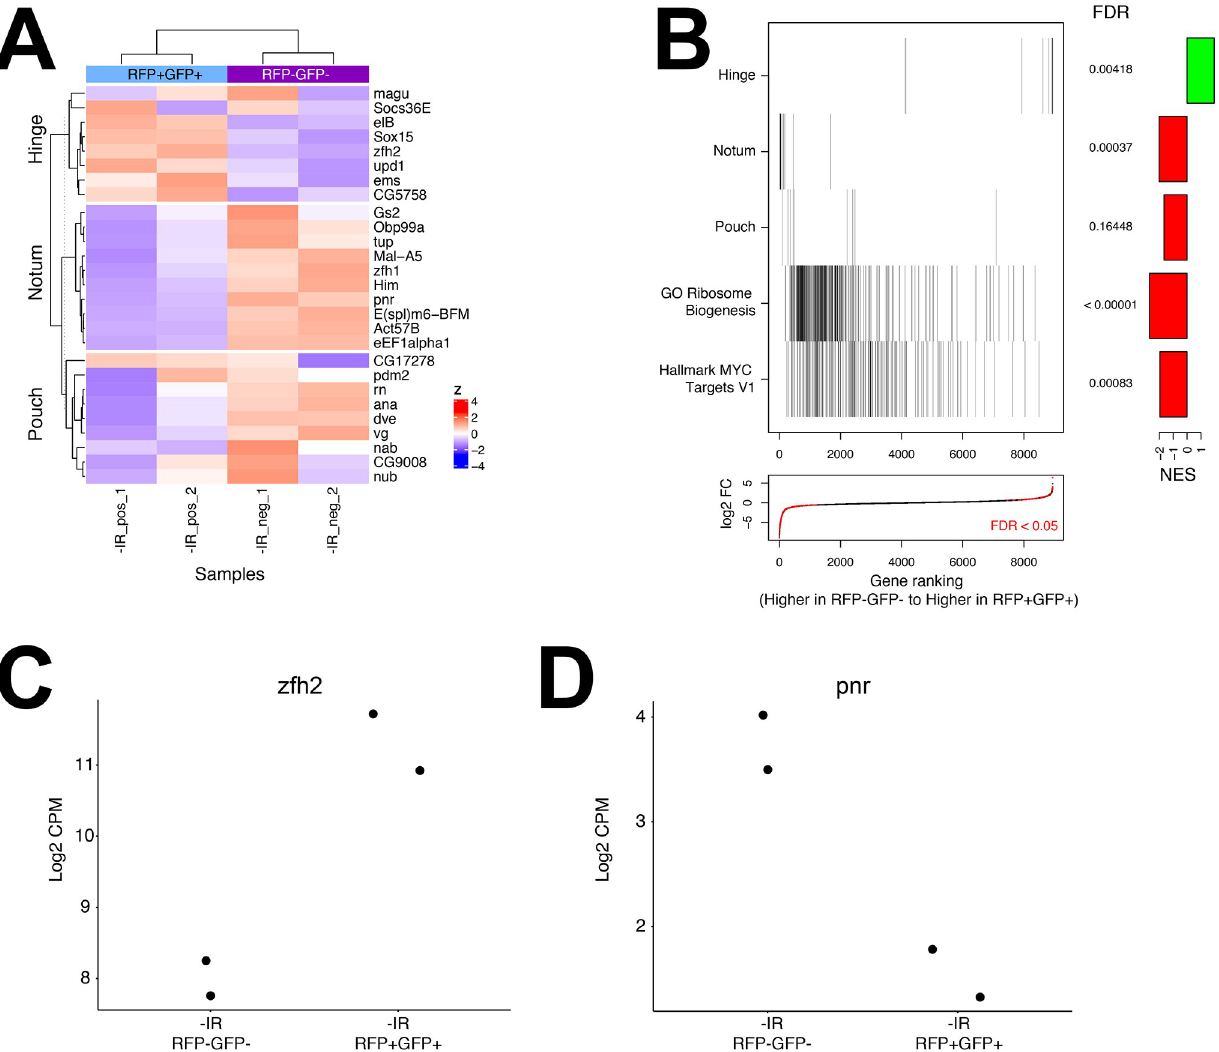
Fig 2. Differential gene expression in POS/pos (RFP + GFP + ) versus NEG/neg (RFP - GFP - ) cells without irradiation. FlyBase nomenclature for gene names is used throughout the manuscript (https://flybase.org). (A) The heatmap shows the expression in POS and NEG cells of genes that are known from the literature to show elevated expression in the hinge, notum, or pouch. (B) Aggregate gene set enrichment scores of the indicated gene sets. Each tick mark represents a gene in the pathway. The barplot shows the normalized enrichment scores (NES, the degree to which a gene set is overrepresented, normalized for gene set size) and p-values adjusted for False Discovery Rate (FDR, estimated probability that a gene set with a given NES represents a false positive finding). See www.gsea-msigdb.org for further definitions. The plot at the bottom shows the fold-changes of genes when comparing POS versus NEG samples in the same order as the pathway data above. Significant (FDR < 0.05) genes are highlighted in red. (C-D) The expression in counts per million (CPM) in POS and NEG cells of zfh2 and pnr, representative transcripts with high expression in the hinge and the notum, respectively. Pairs of dots represent data from two biological